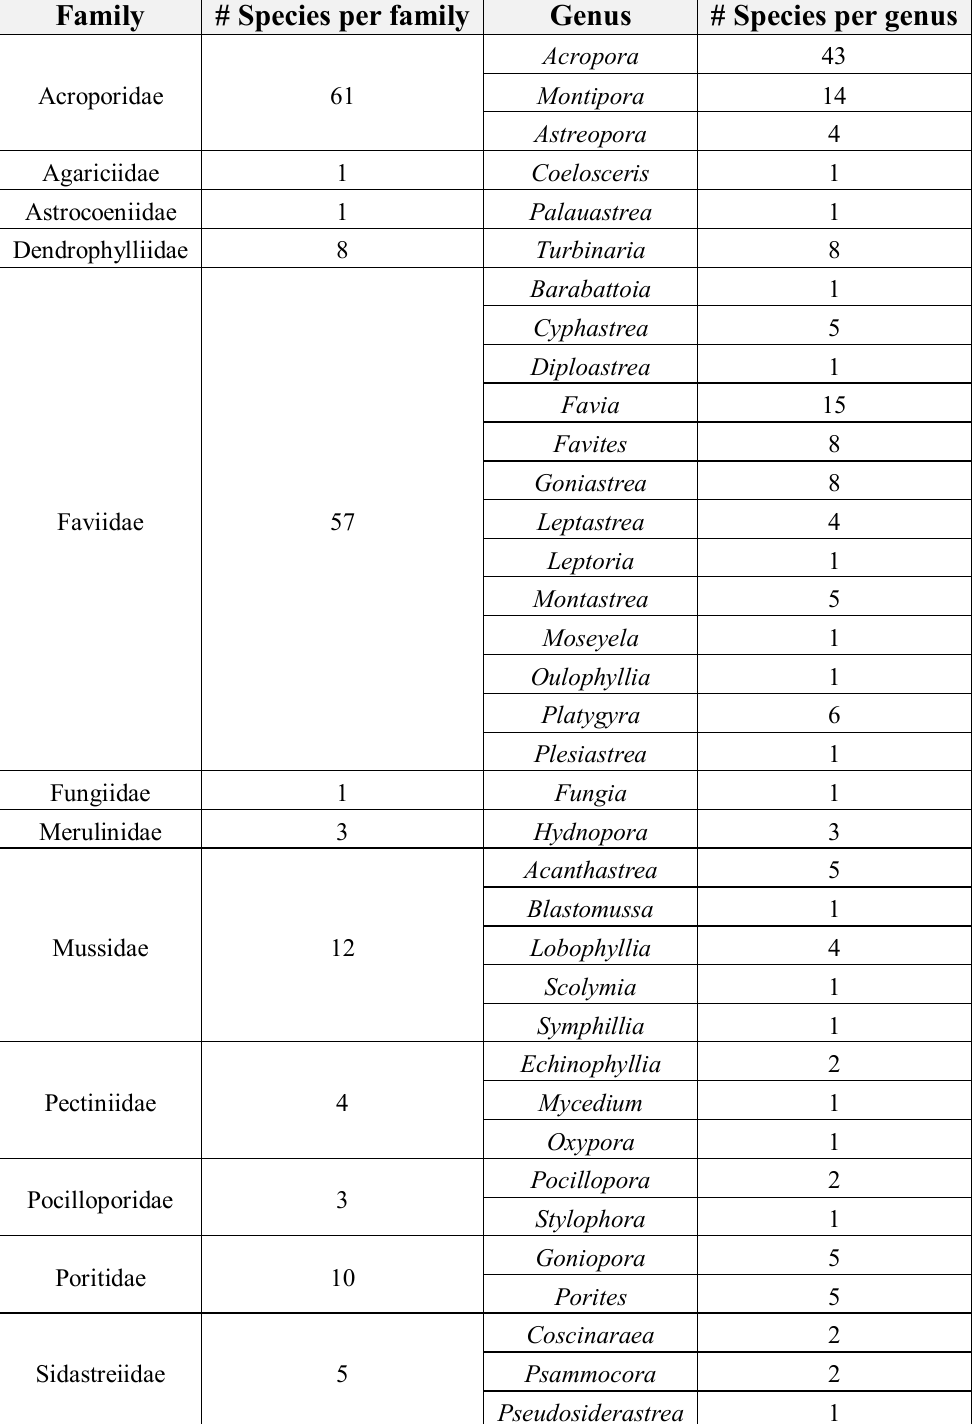
Table 2. The 13 Scleractinian coral families comprising 167 species in 48 genera identified in the